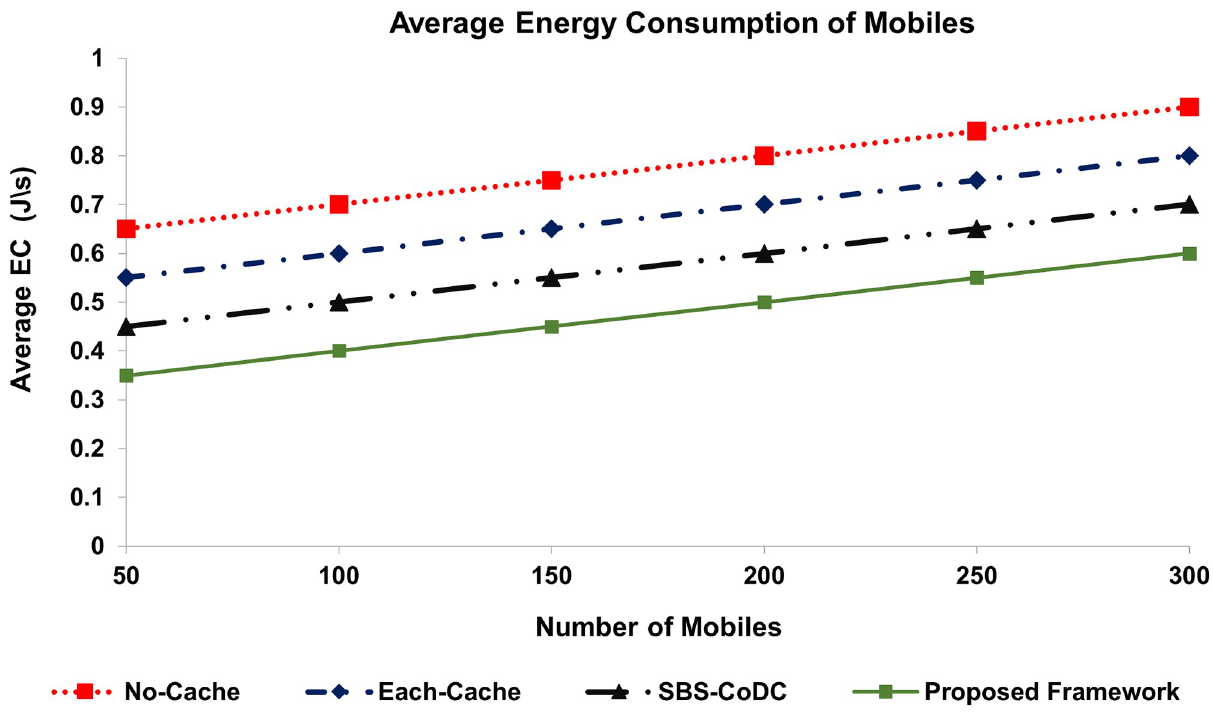
Fig 6. Comparison average energy consumption of MSs.